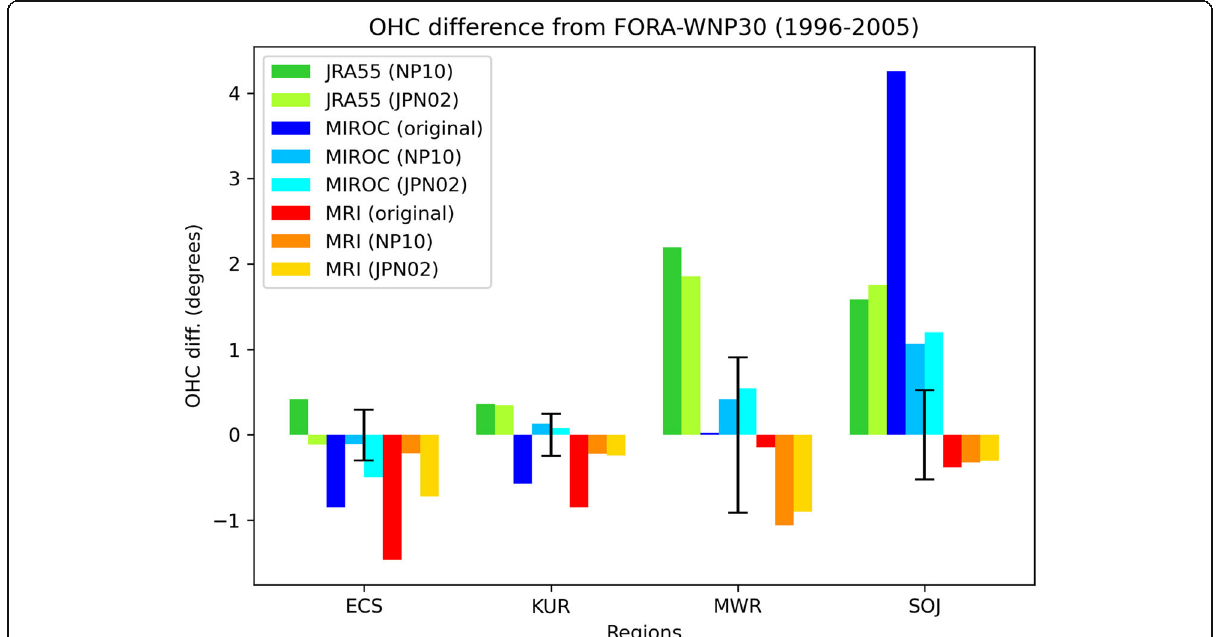
Fig. 4 OHC differences (biases) from the ocean reanalysis (FORA-WNP30) values for four rectangular regions (shown in Fig. 3d), comparing the NP10 and JPN02 results (JRA-55, MIROC5, MRI-CGCM3) and the original CMIP5 results (MIROC5 and MRI-CGCM3) for the historical term (1996 – 2005). The error bar in each region denotes the standard deviation of the monthly OHC for the term 1996 – 2005 from the